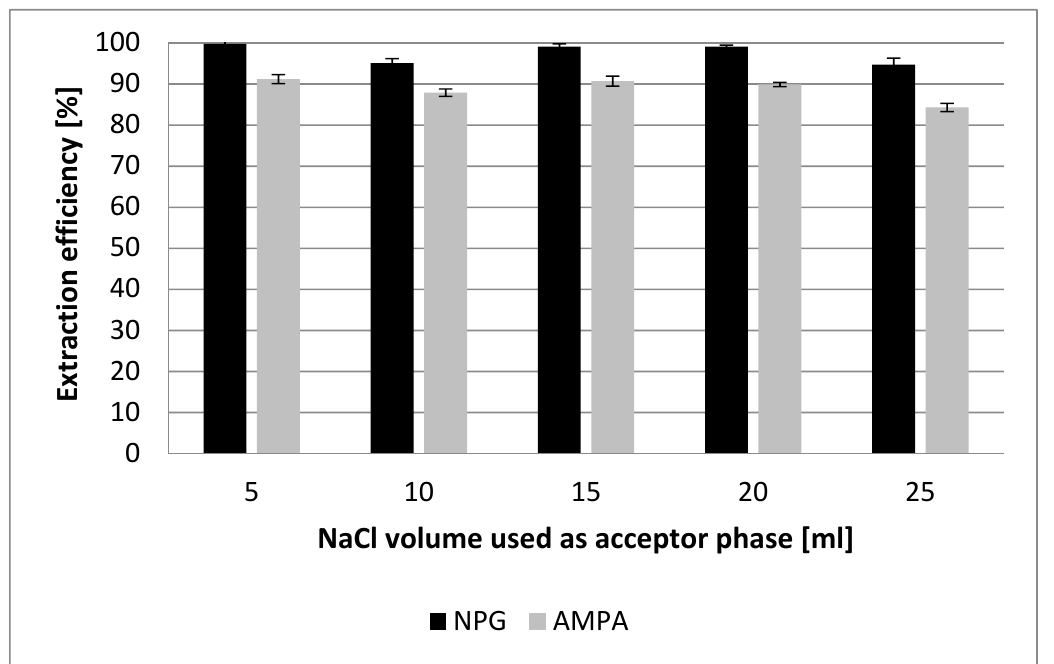
Figure 2. Effect of donor phase volume on extraction efficiency of the studied analytes. (SLM conditions—donor phase: an aqueous solution of NPG and AMPA mixture at a concentration of 0.6 mg L − 1 and pH 11 (sample volume 100 mL); acceptor phase: 2 M NaCl; membrane phase: 20% Aliquat 336 in DHE; the flow rate of the donor and acceptor phase 0.2 mL min − 1 ; extraction time: 24